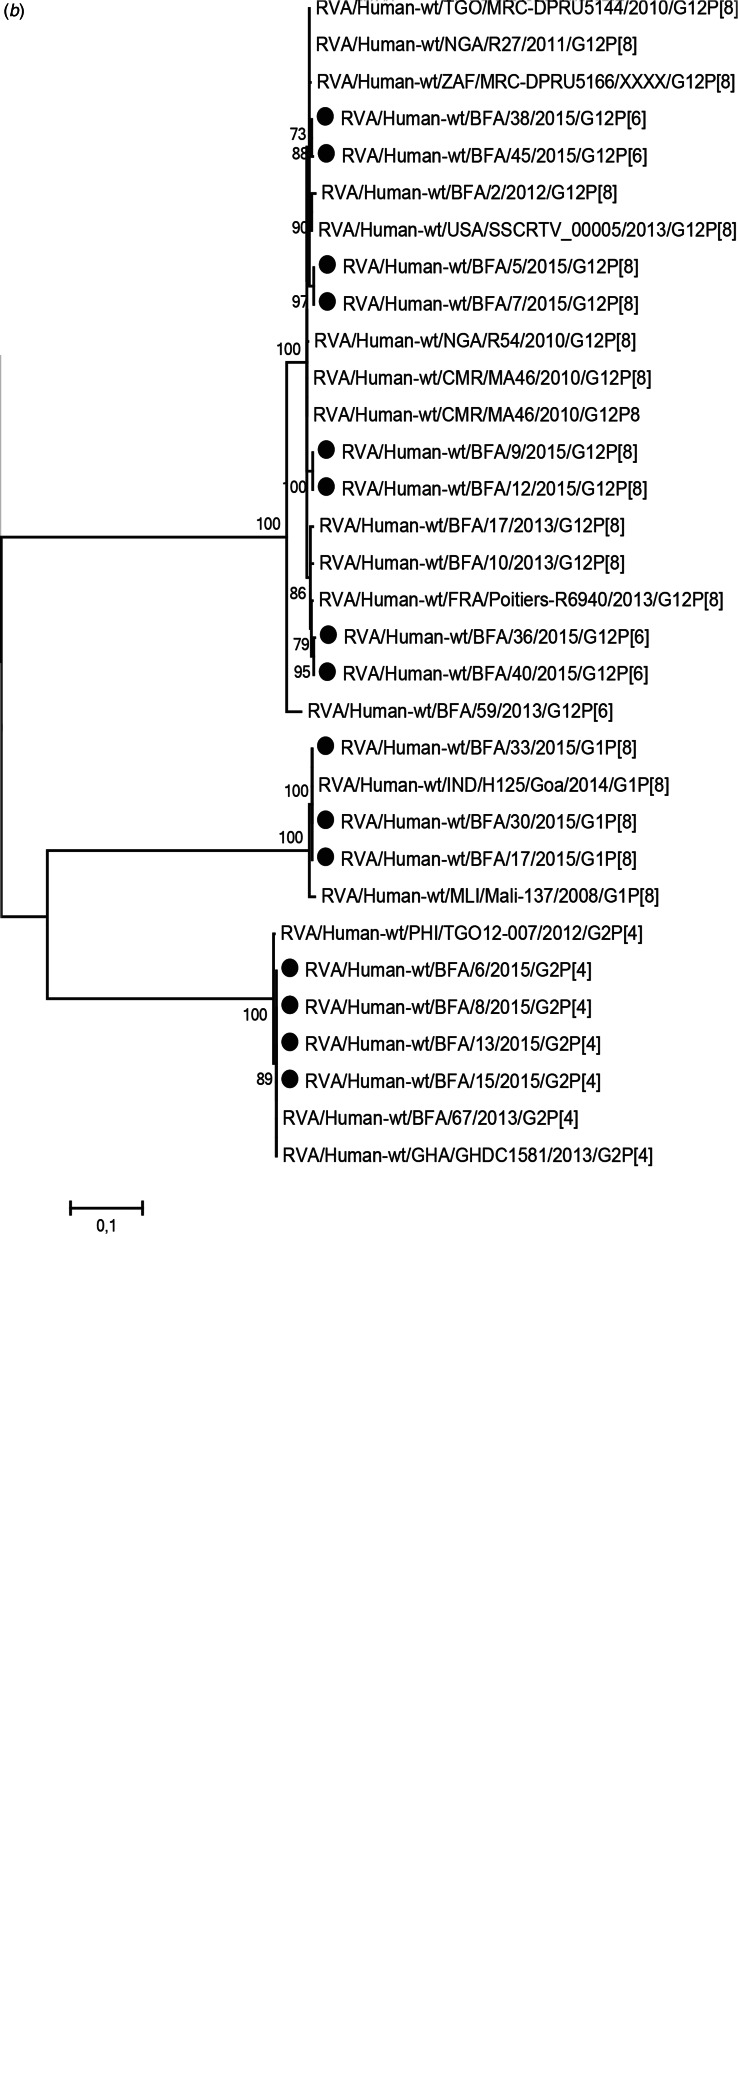
Phylogenetic analysis of sequences of rotavirus. (a) VP4 gene (nt 51-802) and (b) VP7 gene (nt 209–844). The phylogenetic tree contains most similar rotavirus strains found on GenBank and rotavirus strains from Burkina Faso 2013. Scale bars represent the number of substitutions per site and bootstrap values are shown at branch nodes (values <70% are not shown).